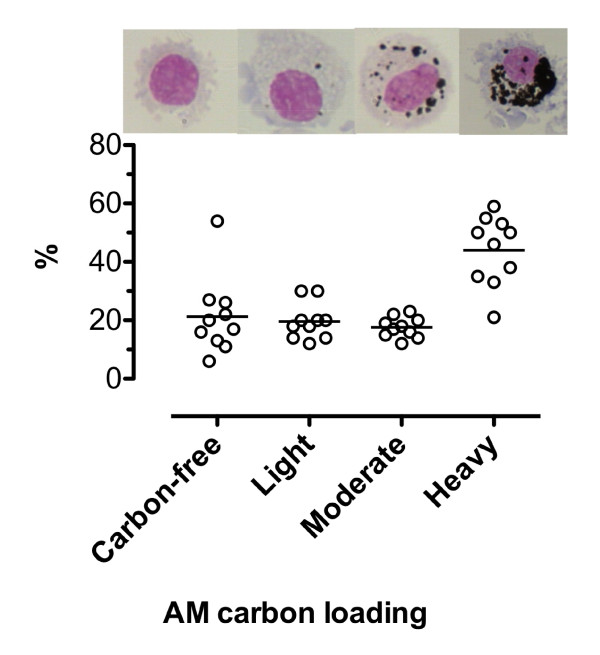
Carbon loading of alveolar macrophages (AM) from uninfected mice exposed to 2× doses of 500 μg ultrafine-carbon black (UF-CB) in 50 μL phosphate buffered saline. Bronchoalveolar lavage was performed 72 h after the second dose on day 4. Carbon loading was assessed semi-quantitatively as described in Methods. Data are from 10 animals. Bar represents mean. Representative images of BAL fluid AM loading are shown in the upper panel.